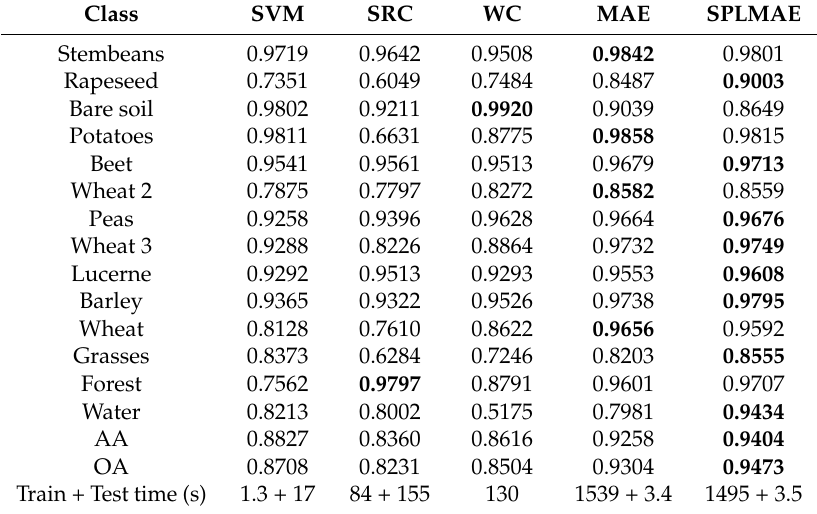
Figure 4. The convergence analysis of the Flevoland dataset from AIRSAR. Table 1. The accuracies of the Flevoland dataset from AIRSAR. AA: average accuracy; OA: overall accuracy.